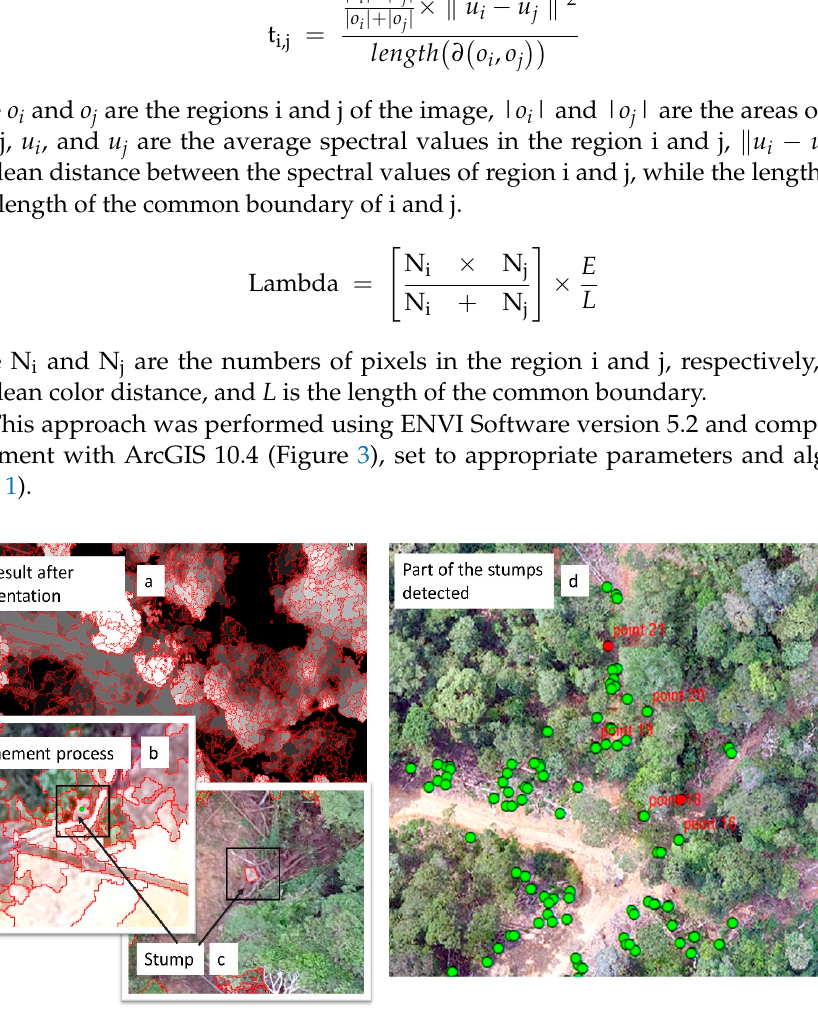
Figure 3. The segmented tree stumps, after segmentation ( a ), the refinement process ( b ), identified stumps ( c ), and part of the identified stumps’ distribution ( d ). stumps ( c ), and part of the identified stumps’ distribution ( d ). Table 1. Parameters and algorithms for the segmentation